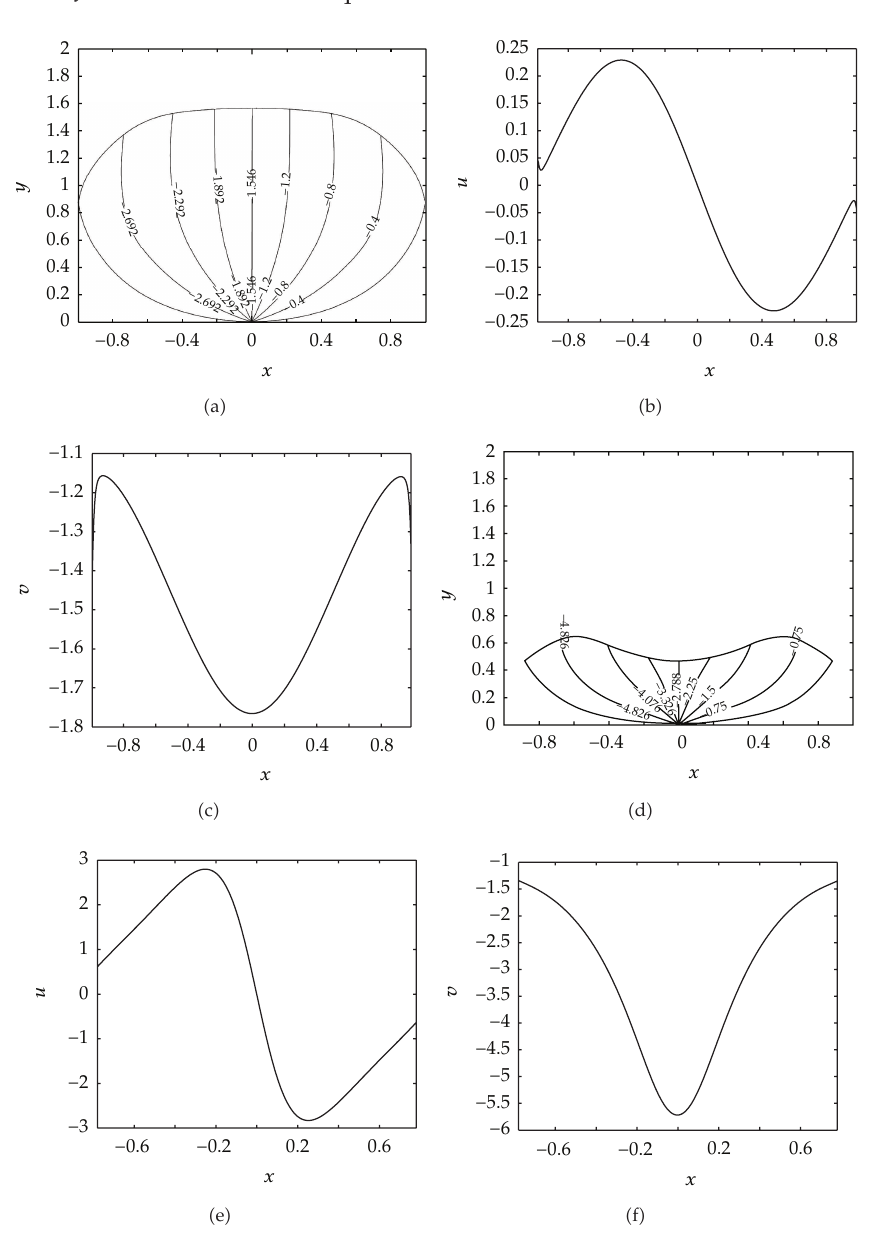
Figure 8: (cid:5) a, d (cid:6) Contour plots of the fluid motion within the modeled two-dimensional collapsing vessel (cid:5) of Figure 3 (cid:6) during micturition, at mid-to-late times. Also plotted are the horizontal (cid:5) b, e (cid:6) and vertical (cid:5) c, f (cid:6) velocities along the horizontal